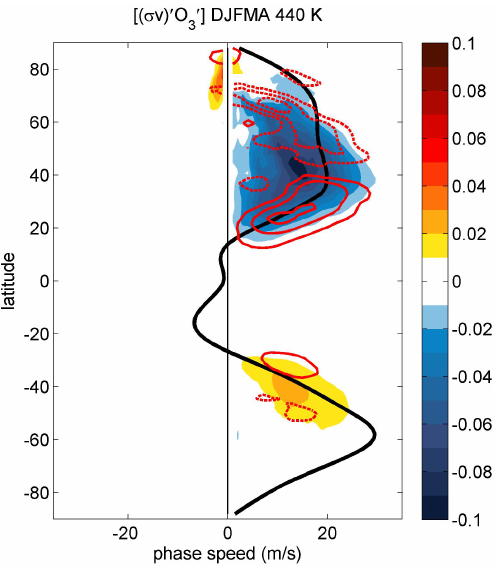
Fig. 10. Latitude versus phase-speed representation of the ozone eddy flux co-spectrum at 440K for the winter-spring season (De- cember through April). The spectrum of the eddy covariance ( (σv) 0 O 3 0 ) is multiplied by the cosine of latitude to emphasize the behavior in low latitudes. Red contours represent the meridional h i (σv) 0 O 3 0 convergence of the eddy flux (term −¯ σ − 1 in Eq. 6); y solid contours indicate convergence of the eddy flux, associated with positive ozone tendencies. The solid black line shows the zonal mean zonal wind. A 9-point running mean in-phase speed is applied to the contours. (Shading units: kgm − 1 s − 1 K − 1 ppmv, contour lev- els spacing is 0.2ppbvday − 1 )